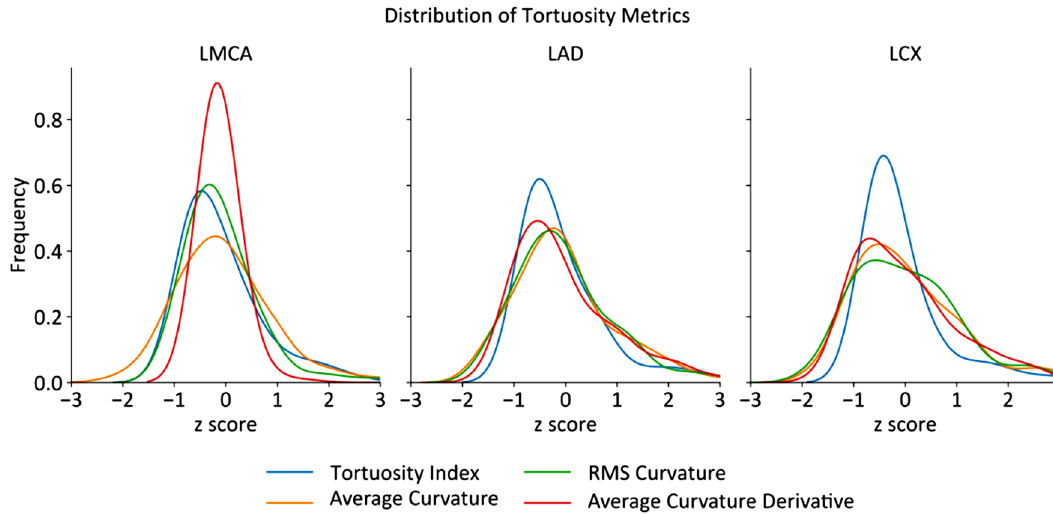
Figure 4. Normalized distribution of tortuosity metrics (n = 127).